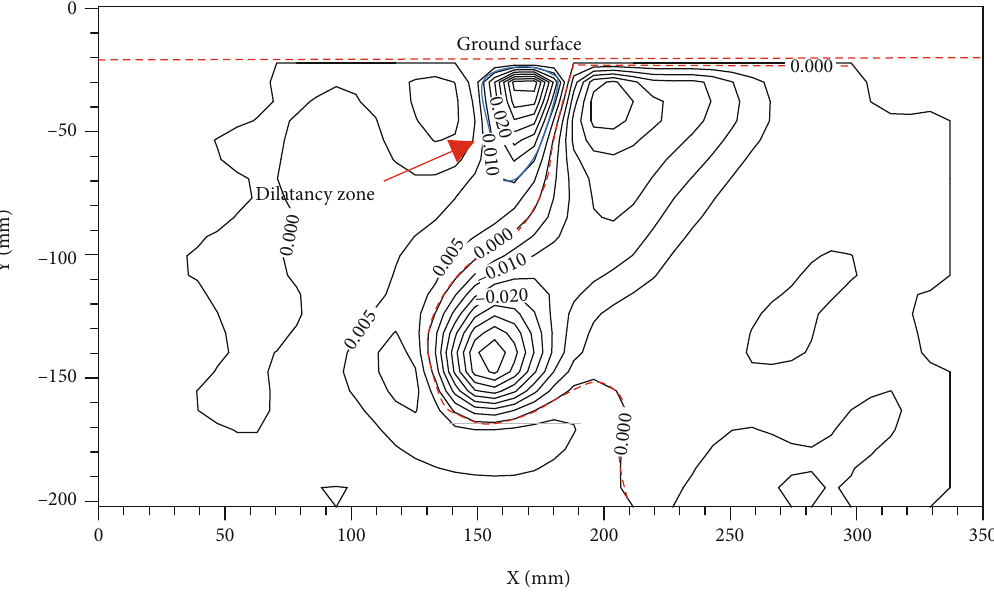
Figure 11: Volume strain fi eld at the ultimate load for D